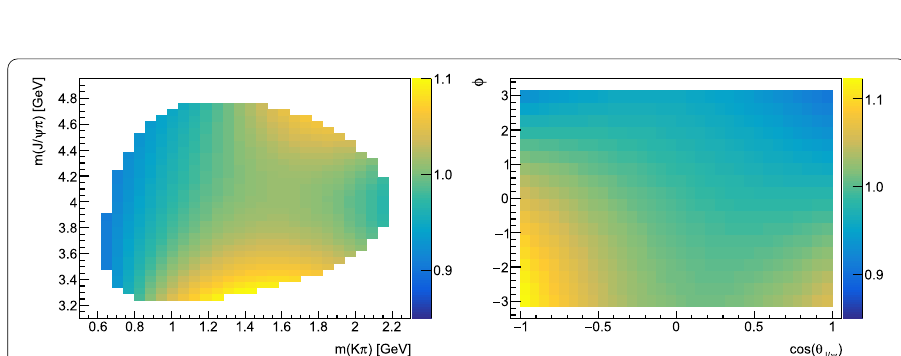
Fig. 8 Comparison of generated and post-fit values of the phase parameters (above) and the corresponding pull distribution (below) obtained when a dataset generated with ten K ∗ s is fitted with the [ten K ∗ s Z (4430)] model. The green lines define a ± 3 σ band. The pulls for the Z components are not defined + because the Z s are not present in the generation model